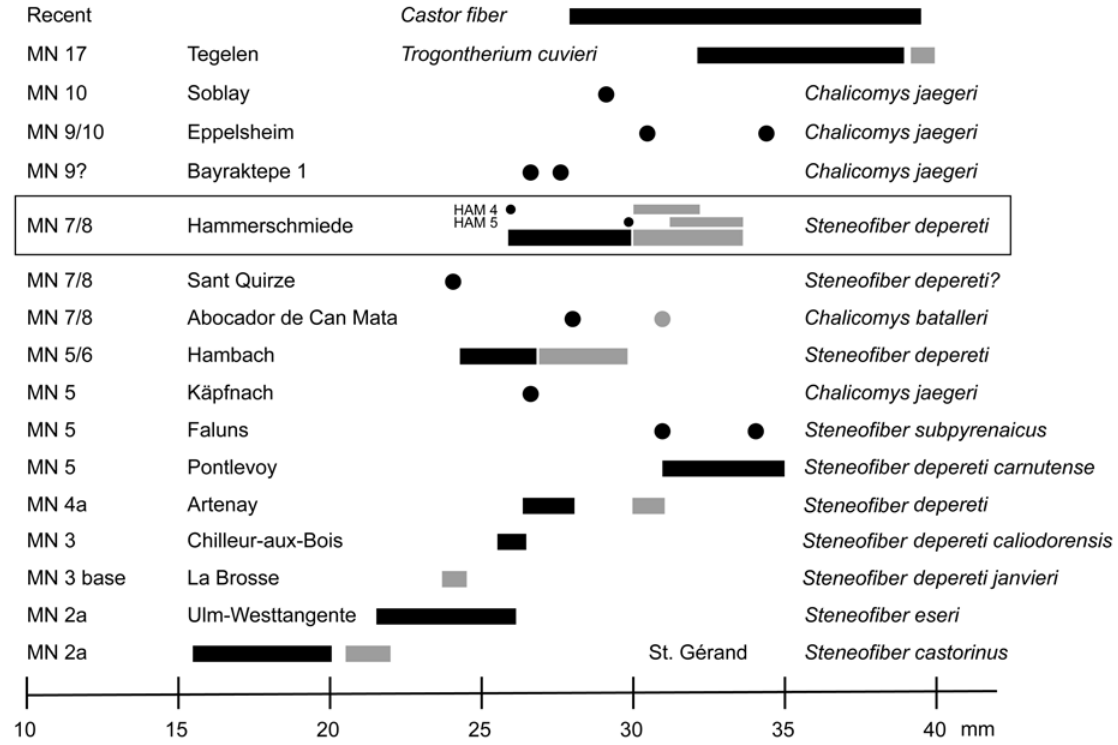
Fig. 9. Mandibular tooth row lengths of the beaver Steneofiber depereti Mayet, 1908, from the early Late Miocene locality Hammerschmiede (Bavaria, Germany), local stratigraphic levels HAM 5 and HAM 4, in comparison to representative European Miocene castorid species. Occlusal surface lengths are given as single measurements (black dots) or ranges (black bars). Alveolar lengths are given in grey dots or bars respectively. Measurements adapted from Stefen (2009), Mörs and Stefen (2010), Stefen (2011), and citations therein. Biostratigraphic positions of the localities according to the Mammal Neogene (MN) zones (sensu Mein